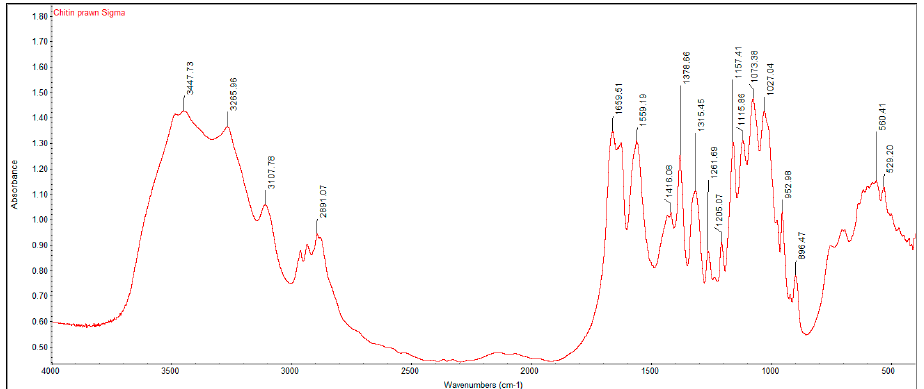
Figure 4. FTIR spectra of commercial chitin.